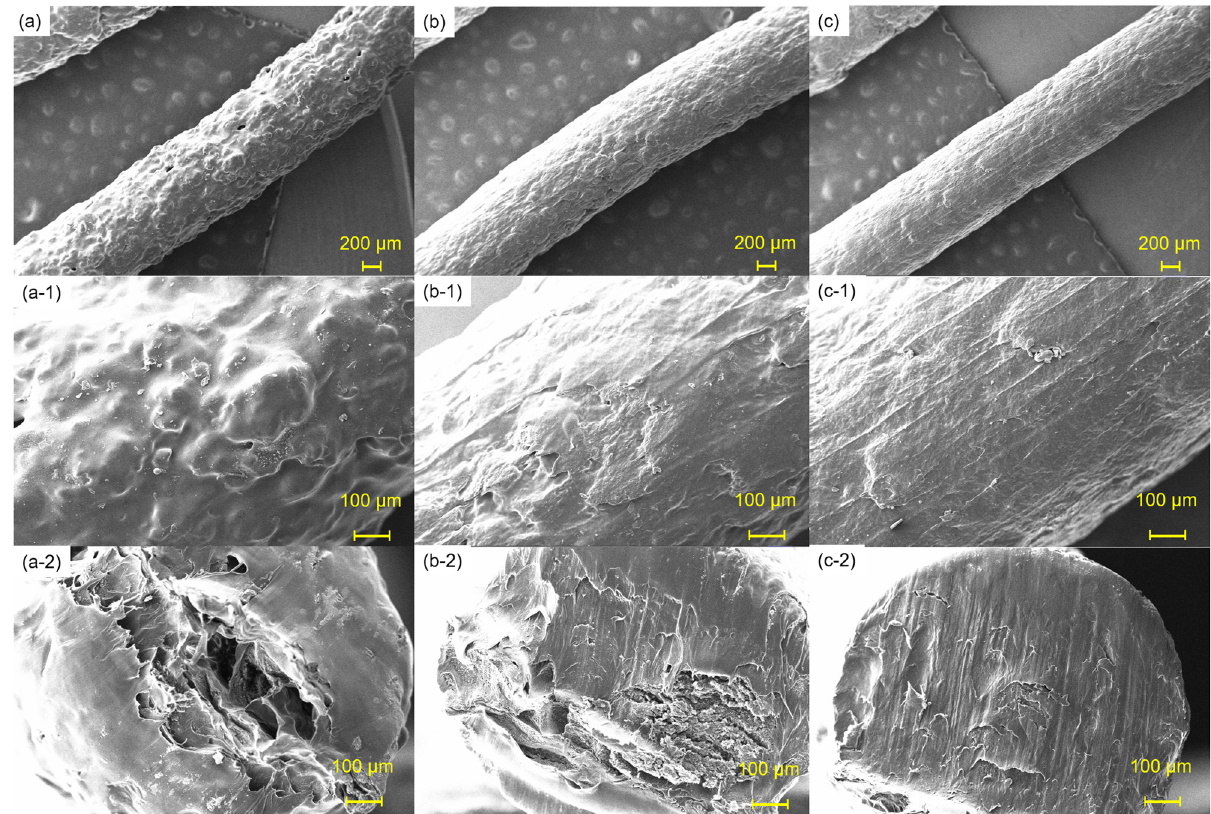
Figure 2: SEM pictures of PACF composite sample: ( a ) 210°C, ( b ) 230°C, and ( c )